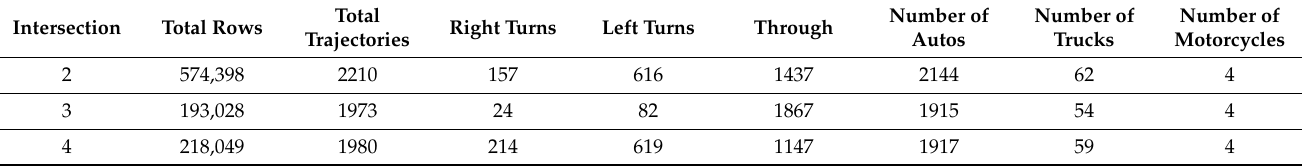
Table 3. Dataset